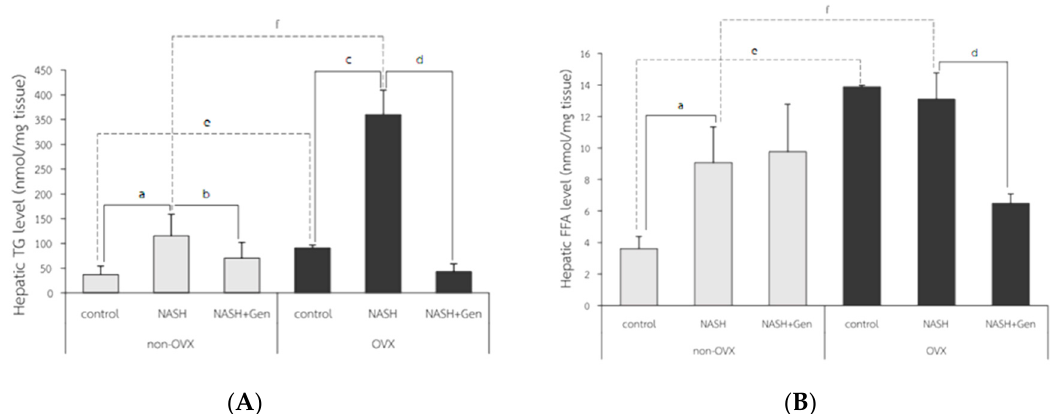
Figure 6. Colorimetry analysis of ( A ) hepatic triglyceride (TG) level and ( B ) hepatic free fatty acid (FFA) level. a: p < 0.05 comparison between control and NASH groups of non-OVX rats. b: p < 0.05 comparison between NASH and NASH+Gen groups of non-OVX rats. c: p < 0.05 comparison between control and NASH groups of OVX rats. d: p < 0.05 comparison between NASH and NASH+Gen groups of OVX rats. e: p < 0.05 comparison between control groups of non-OVX and OVX rats. f: p < 0.05 comparison between NASH groups of non-OVX and OVX rats.